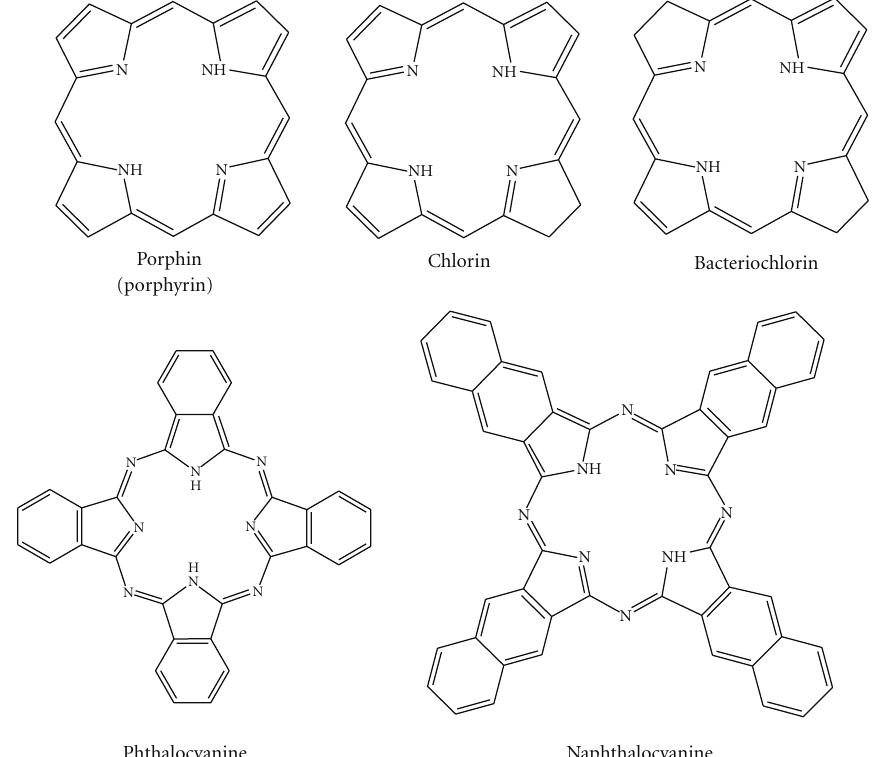
Figure 2: Chemical structure of various